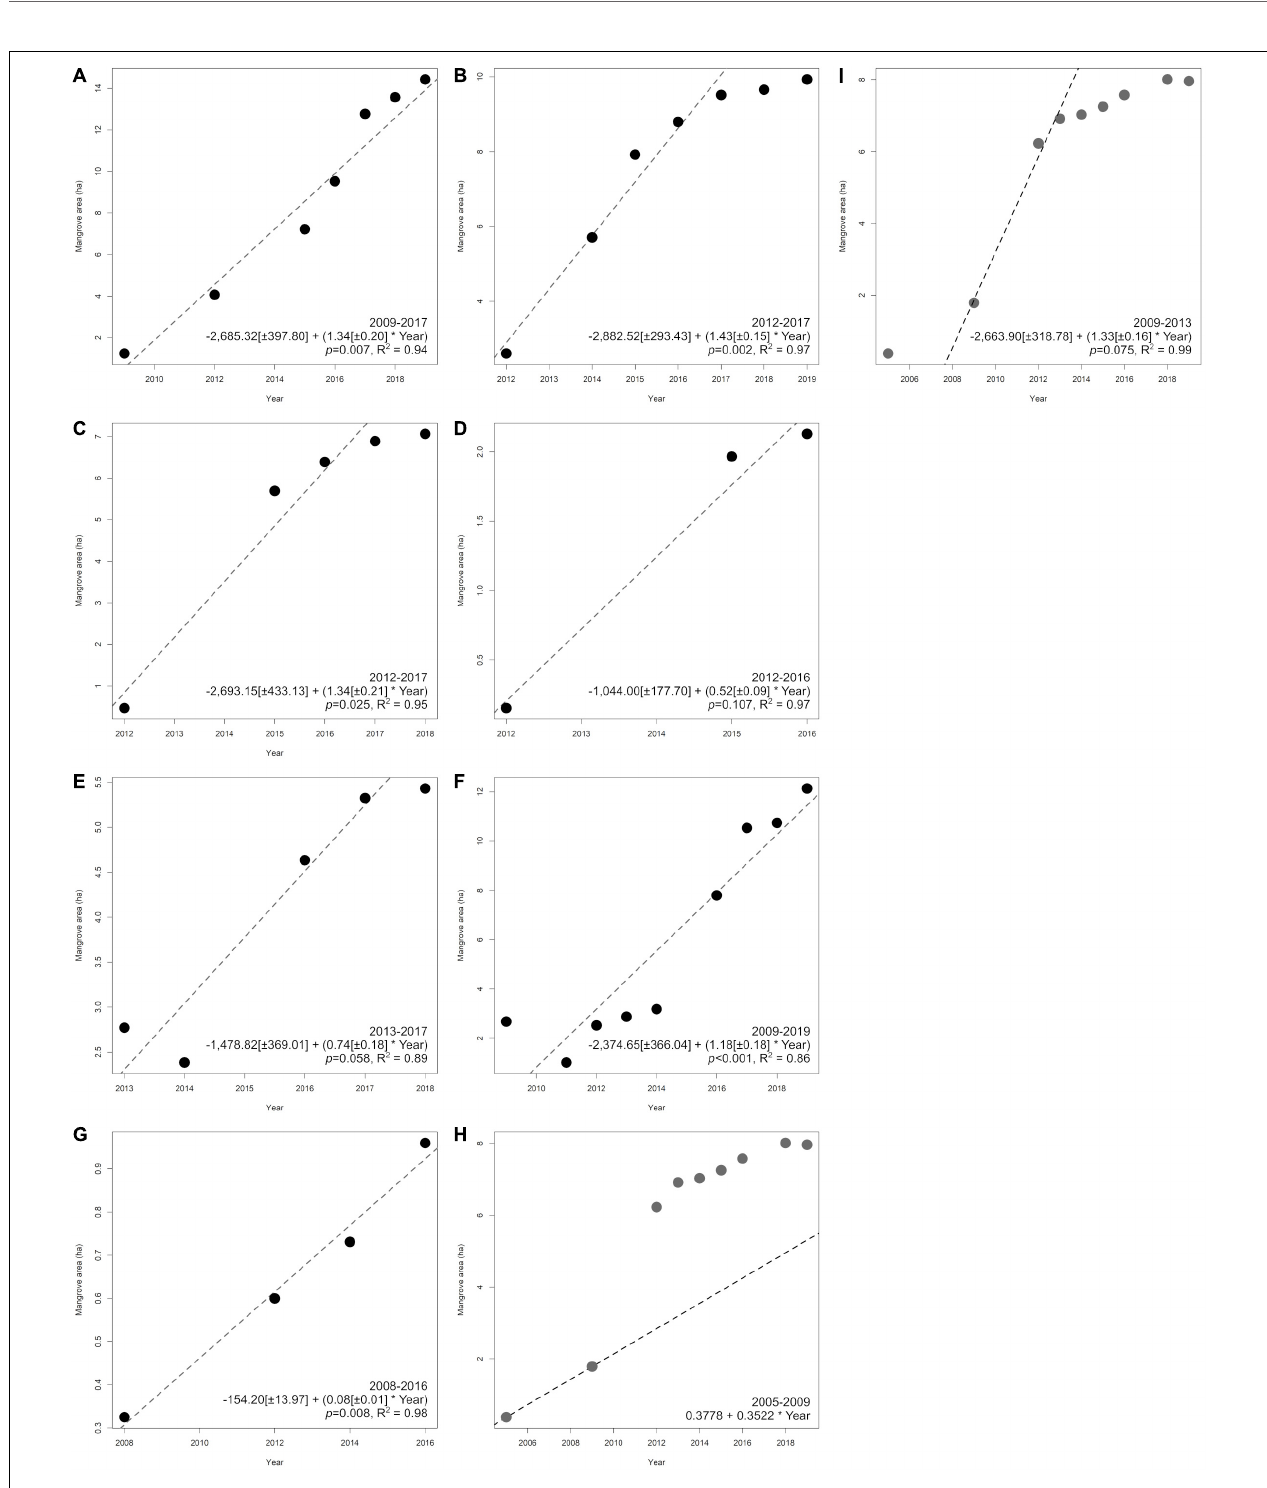
FIGURE 3 | Plots of mangrove area (ha) through classified time-series high-resolution RGB GE imagery to identified “leveling-off” of rates areal gain for all abandoned aquaculture ponds [rates in ponds (D,F,G) were not observed to “level-off” within the analyzed time-series]. Dashed lines show time-series linear regression models of mangrove area (ha) predicted by time (year). Naturally-regenerating abandoned ponds: (A) Buenavista, Guimaras; (B) Balagon and Napnud, Leganes; (C) Barotac Nuevo; (D) San Dionisio; (E) Panay; (F) Roxas City; (G) Basiao, Ivisan. Actively-rehabilitated abandoned pond (planting): (H) natural regeneration (NR) pre-planting (2005-2009) and (I) assisted natural regeneration (ANR) with planting (2009-2013) at Leganes Katunggan abandoned pond. N.B. “rate of areal increase” (ha year − 1 ) was calculated from a real change between the two time-points of 2005 and 2009 imagery and a constant rate applied to year 2019 for Leganes Katunggan abandoned pond in panel (H) (see also Table 3